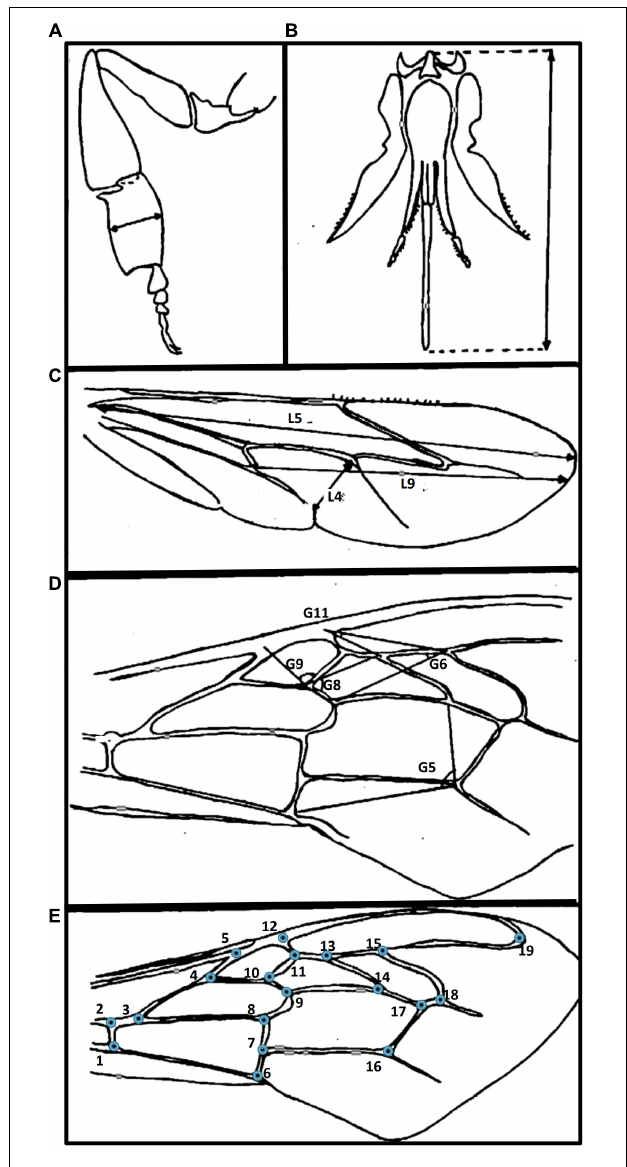
FIGURE 2 | Scheme of honey bee body parts used for morphometric analyses. In brackets variables measured in the present work. (A–D) Traditional morphometry: (A) right hind leg (metatarsal width); (B) mouthparts – proboscis (proboscis length); (C) right hind wing (three internal length); (D) right fore wing (five angles); and (E) geometric morphometry: right fore wing (19 landmarks plotted in the vein